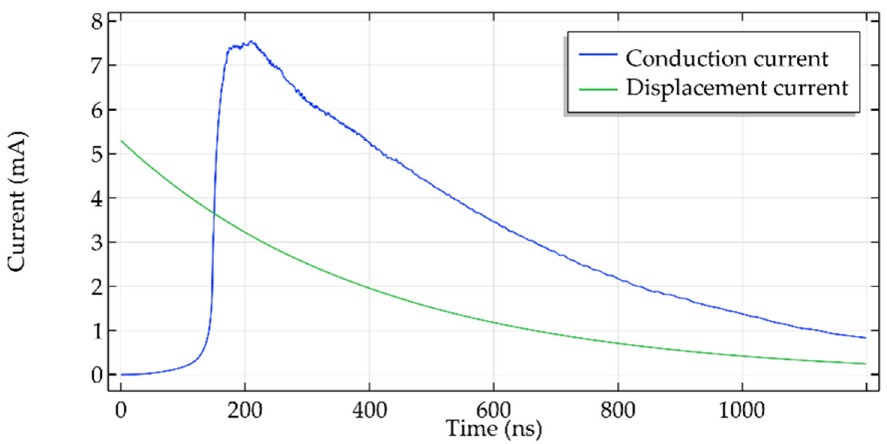
Figure 12. Conduction and displacement currents as a function of time (ns) in the 1st case.